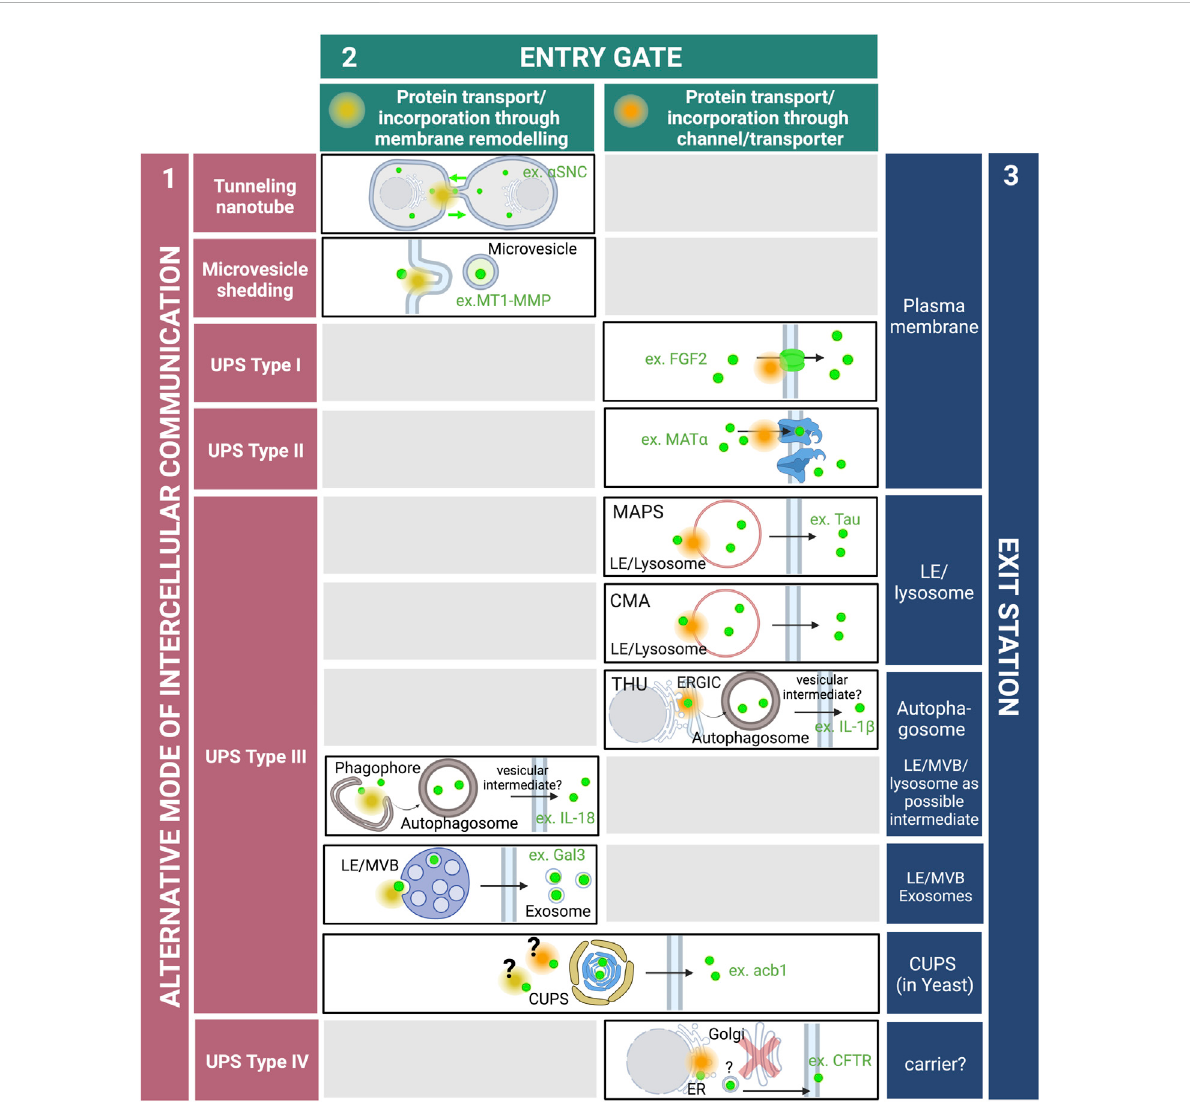
FIGURE 1 Roads and hubs of unconventional protein secretion. In addition to the conventional ER-Golgi secretory pathway, cells are endowed with additionalroutesfortheexportofcytoplasmicproteins,andmultiplemodesofintercellularcommunicationshavebeencharacterized(purple).They includetunnellingnanotubesformedbymembranousprotrusionsthatemergefromthePMandconnectadjacentcells.Tunnellingnanotubesallow the direct transfer of cytoplasmic proteins as well as whole organelles such as lysosomes. Outward budding of the PM produce microvesicles that are then released into the extracellular space. In types I and II UPS, cargo proteins are directly translocated across the PM by pore formation or ABC transporters, respectively. In type III UPS, cargo proteins are incorporated into intracellular compartments and transported through single or successive membrane intermediates that fuse with the PM. In type IV UPS or Golgi-bypass, integral membrane proteins are inserted into the ER and then reach the PM independently of the Golgi apparatus. Along these alternative secretory routes, cargo proteins are transported or incorporated withinmembranecompartmentseitherbyproteinchannelsorbymembraneremodelingde fi ningdistinctentrygatesatthePMoralongintracellular traf fi cking pathways (green). Cargo proteins can also be gathered into particular membrane intermediates prior to release into the extracellular space, de fi ning distinct exit stations (blue). Abbreviations – α SNC: alpha-synuclein; acb1: acyl-CoA-binding protein; CFTR: cystic fi brosis transmembrane conductance regulator; CUPS: Compartment for unconventional protein secretion; CMA: Chaperone-mediated autophagy; ER: Endoplasmic reticulum; ERGIC: ER-Golgi intermediate compartment; FGF2: Fibroblast growth factor 2; Gal3: Galectin-3; IL: Interleukin; LE: Late endosome;MAPS: Misfolded-associated proteinsecretion; MT1-MMP: Membrane-type 1matrix metalloproteinase; MVB:Multivesicular body;THU: TMED10-channeled UPS; UPS: Unconventional protein secretion. The fi gure was generating using